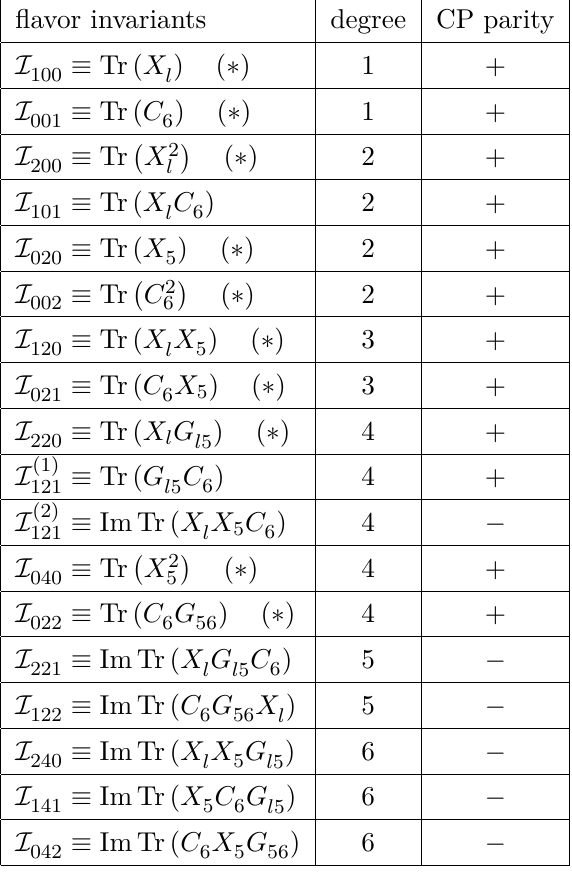
Table 1 . Summary of the basic flavor invariants along with their degrees and CP parities in the SEFT for two-generation leptons, where the subscripts of the invariants denote the degrees of , C and C , respectively. Note that we have defined X X ≡ Y Y † 5 6 l l l that transform adjointly under the flavor-basis transformation. There are totally G ≡ C C ∗ C † 56 5 6 5 12 CP-even and 6 CP-odd basic invariants in the invariant ring of the flavor space. The 10 primary invariants that are algebraically independent have been labeled with “ ( ∗ ) ” in the first